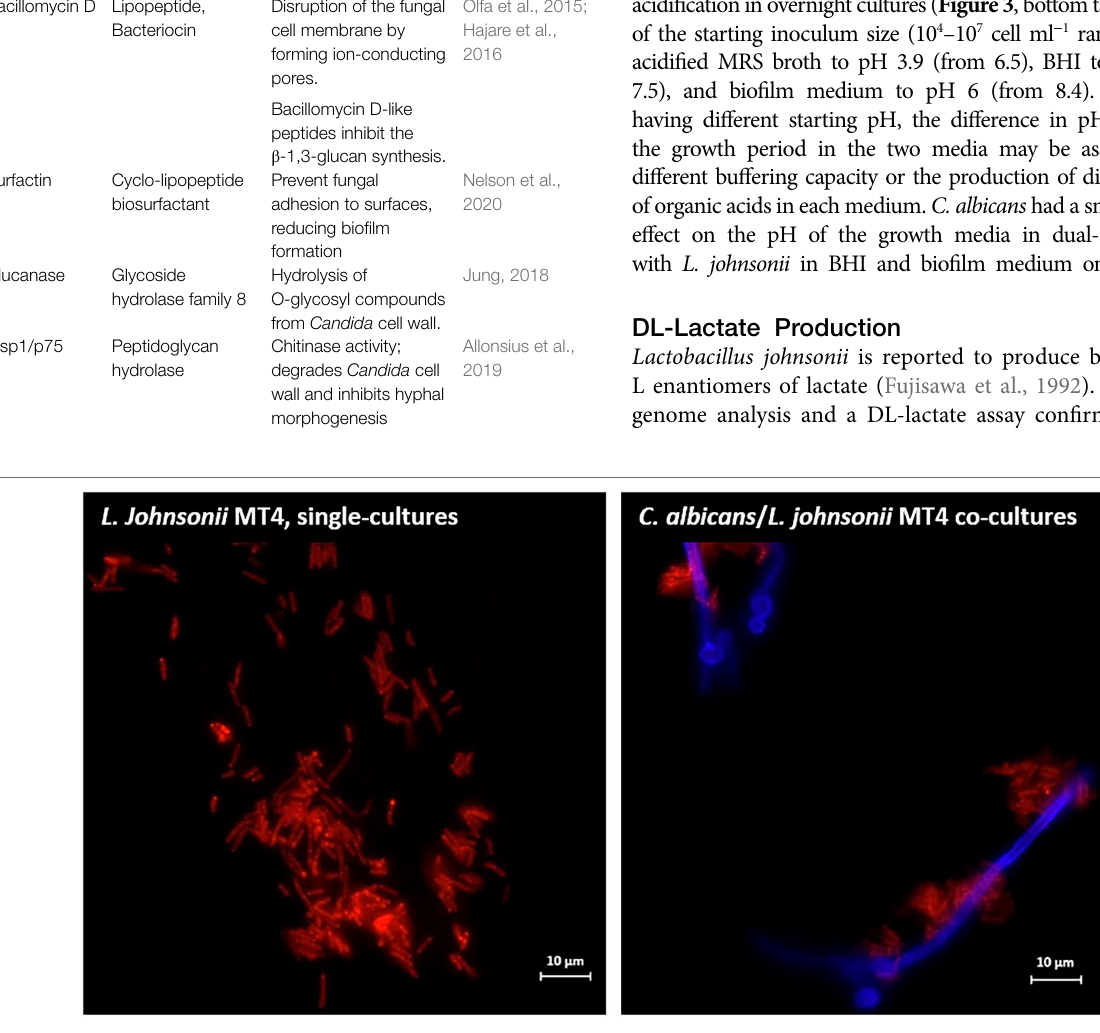
FIGURE 2 | Lactobacillus johnsonii co-aggregates with Candida albicans cells. L. johnsonii (red) auto-aggregates and co-aggregates with C. albicans (blue). The yeast and the lactobacilli were grown on biofilm media for 3 h. Lactobacilli were found in physical proximity with Candida cells, particularly along the hyphae. Scale bar = 10 μ m.